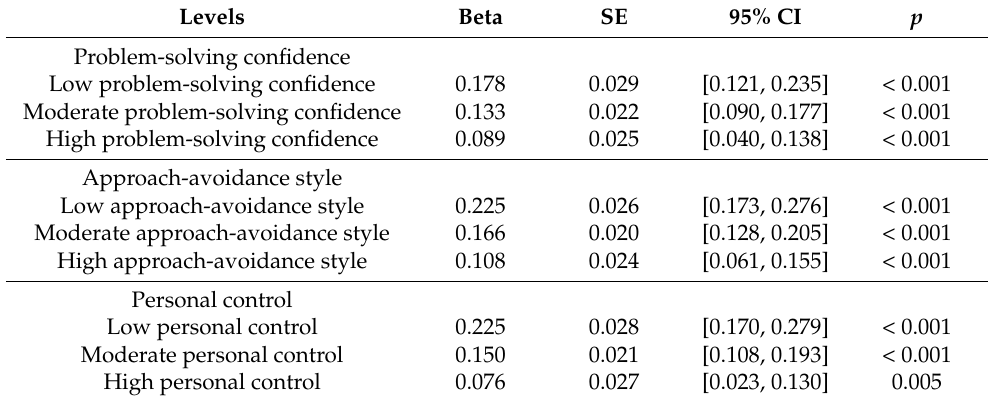
Table 4. The relationship between stress and hopelessness at different levels of problem-solving